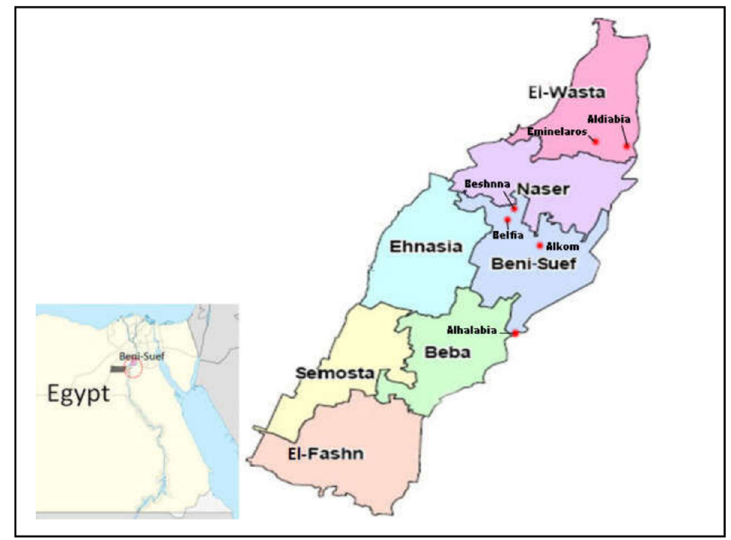
Figure 1. Map of the study area within Beni-Suef province, Egypt. Red dots indicate tick collection sites.